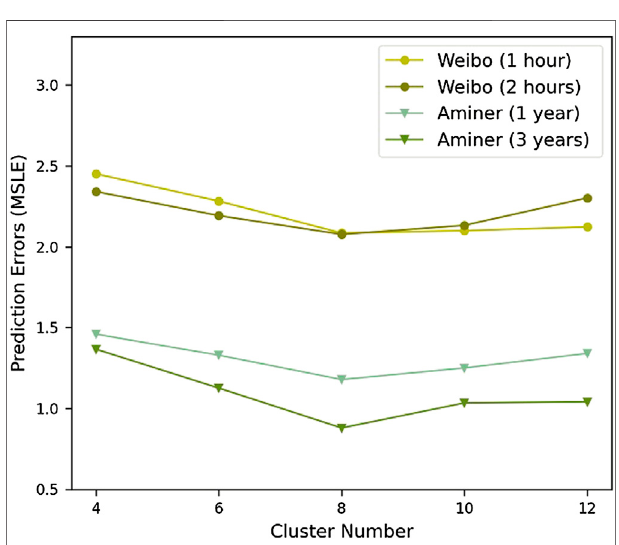
FIGURE 3 | Prediction results under different cluster